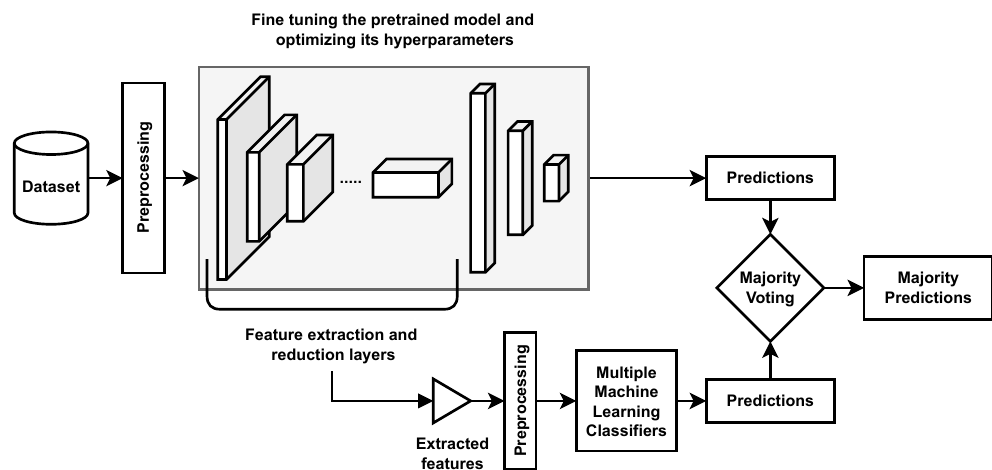
Figure 2. Graphical presentation of the suggested methodology.